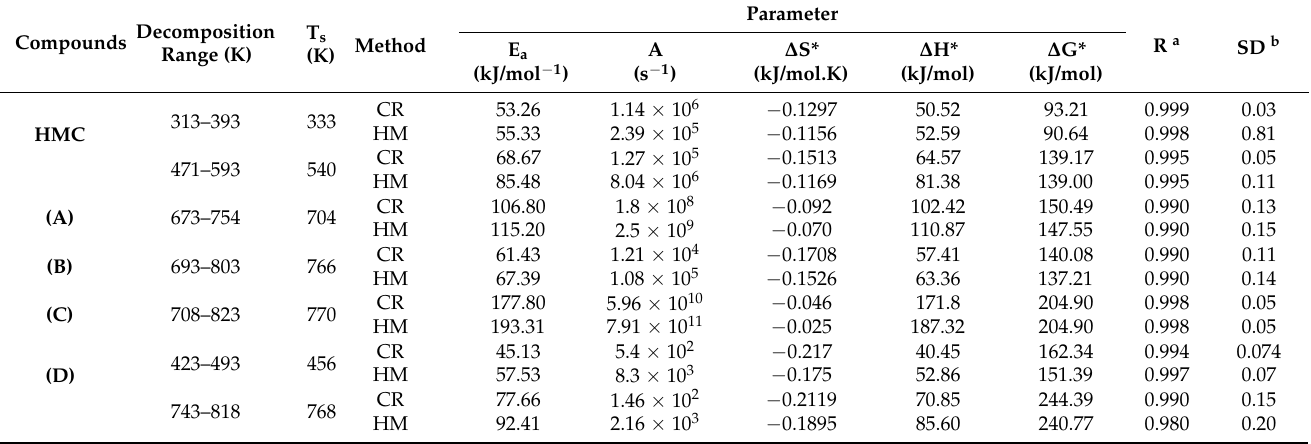
Table 6. Thermal behavior and kinetic parameters determined using Coats–Redfern (CR) and Horowitz– Metzger (HM) equations, operated for HMC and their Zr(IV) complexes (A) , (B) , (C) , and (D) . Decomposition Compounds Range